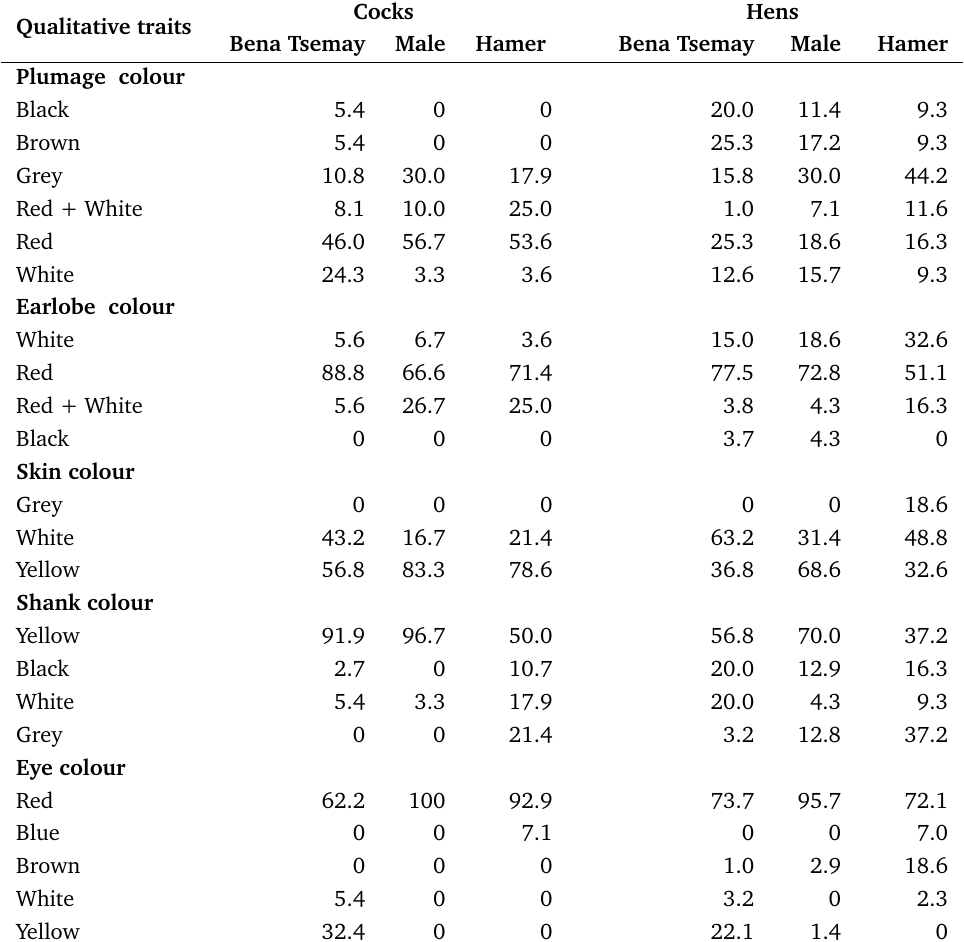
Table 7. Percentages of some colour-related qualitative traits of the chicken populations from different districts. Cocks Hens Qualitative traits Bena Tsemay Male Hamer Bena Tsemay Male Hamer Plumage colour Black 5.4 20.0